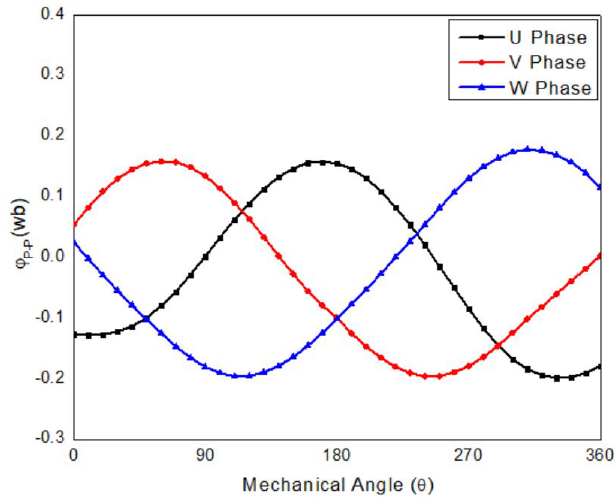
Figure 7. No-load flux linkage of the proposed